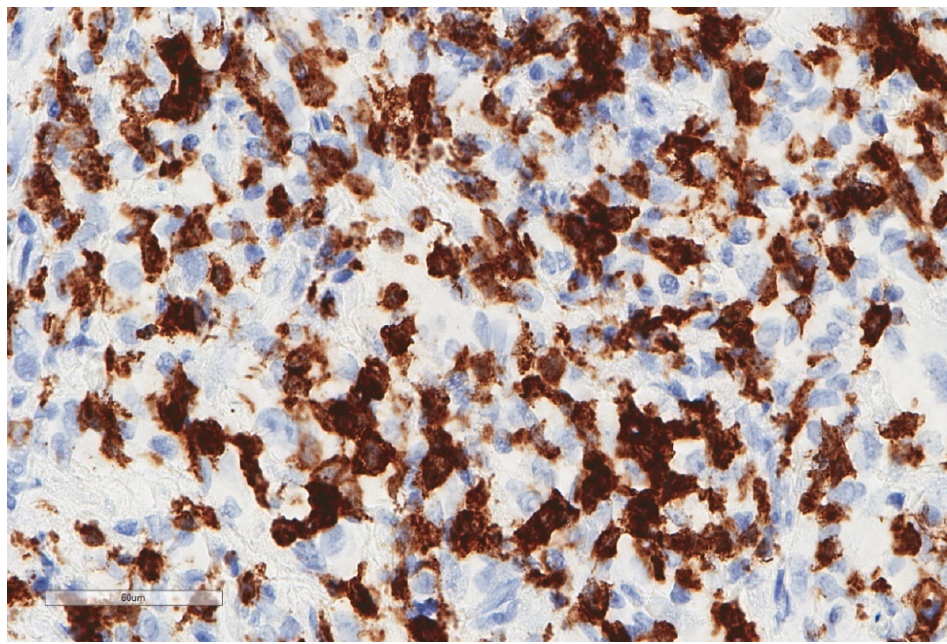
Figure 5. Heavy CD8 intratumoral infiltrate in the malignant mesothelioma case shown in Figure 1 (X400) . (X400).